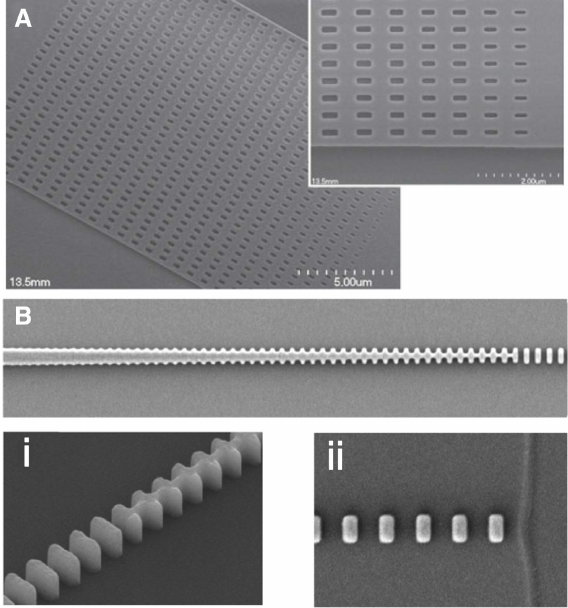
Figure 17: Experimental demonstration of SWG couplers for fiber-chip interconnects. (A) Scanning electron microscopy image of the fabricated continuously apodized SWG surface grating coupler. Inset: detailed view. Reprinted from Benedikovic et al. [90]. Copyright © 2014 by John Wiley and Sons. (B) Scanning electron microscopy image of the SWG edge nanocoupler. Insets (i) and (ii) show the coupler tip and the intermediate section positioned at 15 μ m from the junction with silicon wire waveguide, respectively. Reprinted from Cheben et al. Figure 16: Experimental demonstration of an SWG multimode waveguide bend. (A) Field distribution of the TE mode when passing through the SWG 3 waveguide bend. (B) Measured transmission spectra when the TE 3 mode is launched into the waveguide bend. Reprinted from Wu et al.